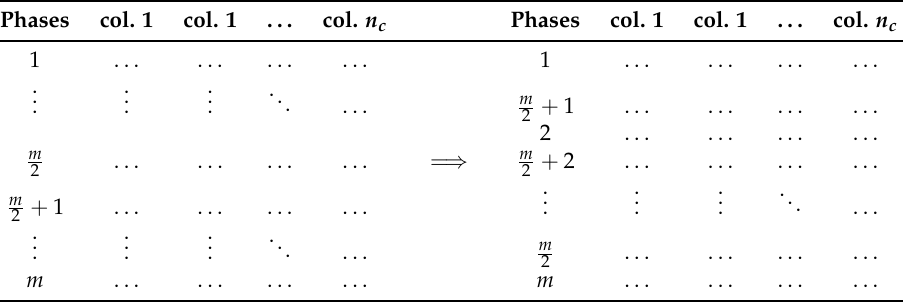
Table 6. Reordering of the rows of a WDT for an m-phase reduced system winging with m ∈ G .